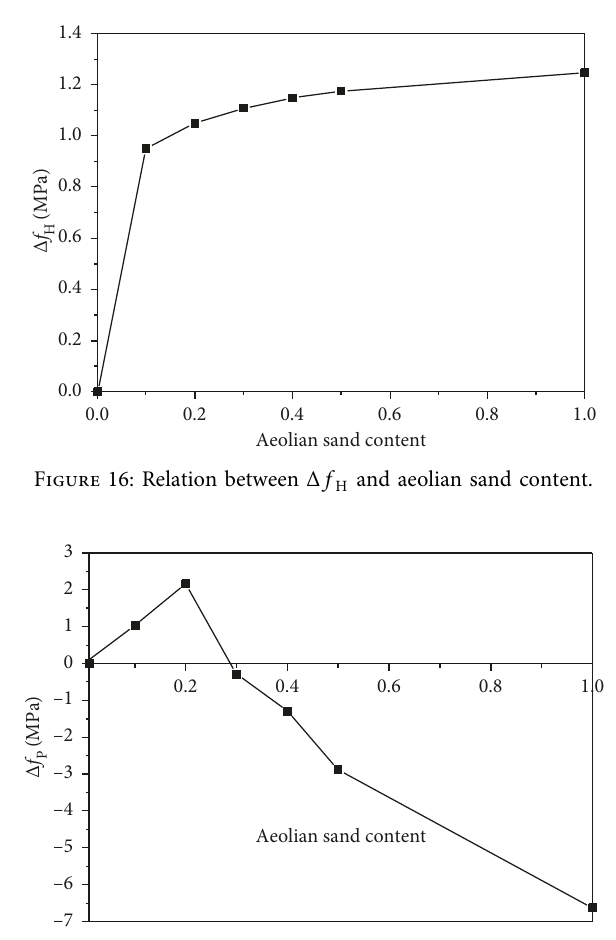
and aeolian sand P